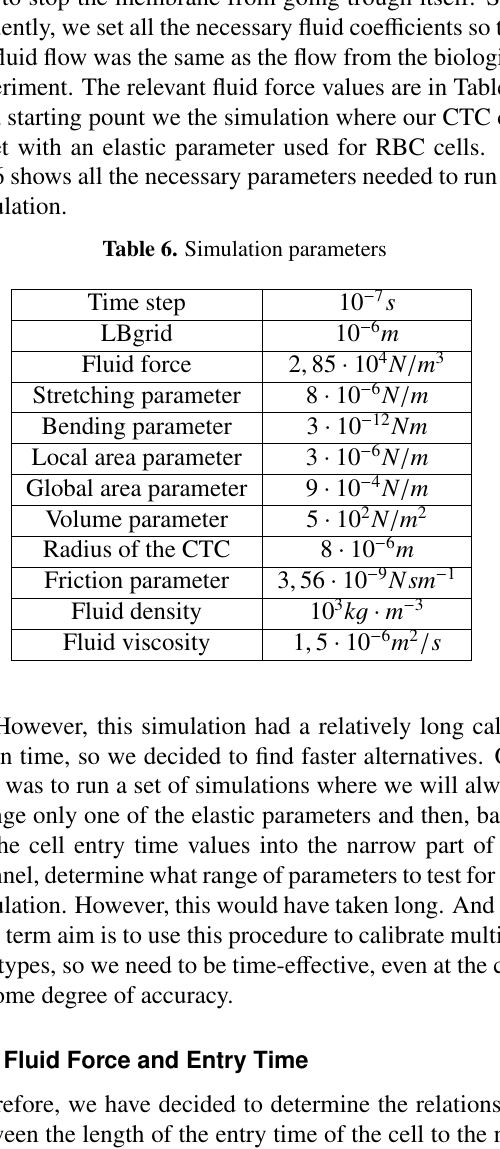
Table 5. Values measured in biological experiment [3]